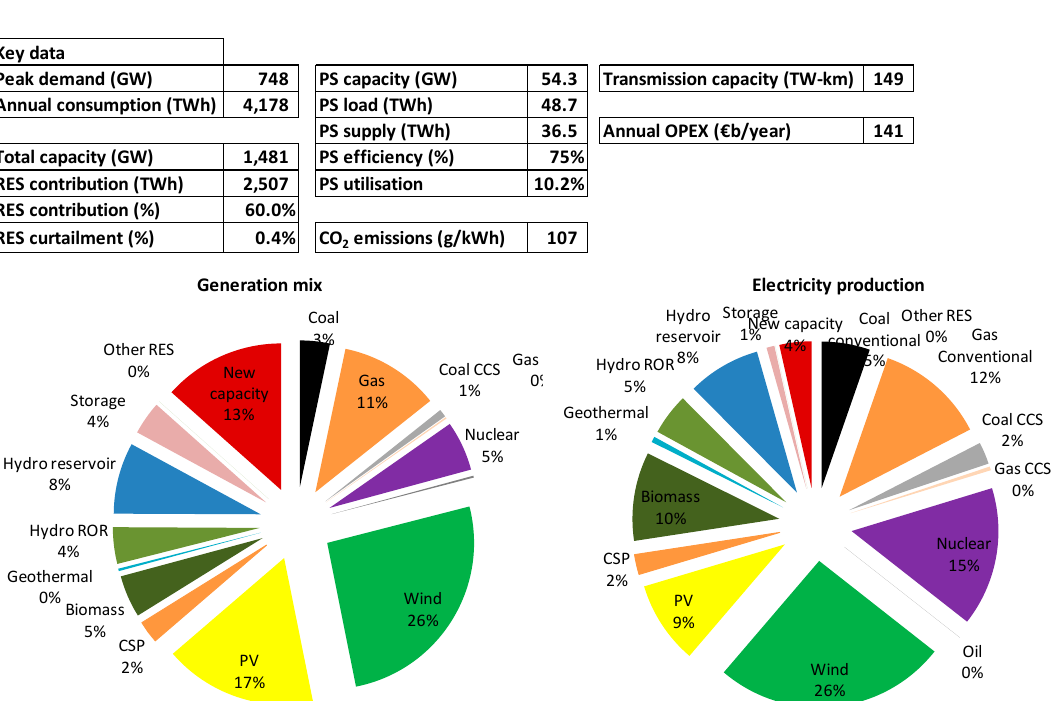
Figure A5. High RES scenario for 2020.